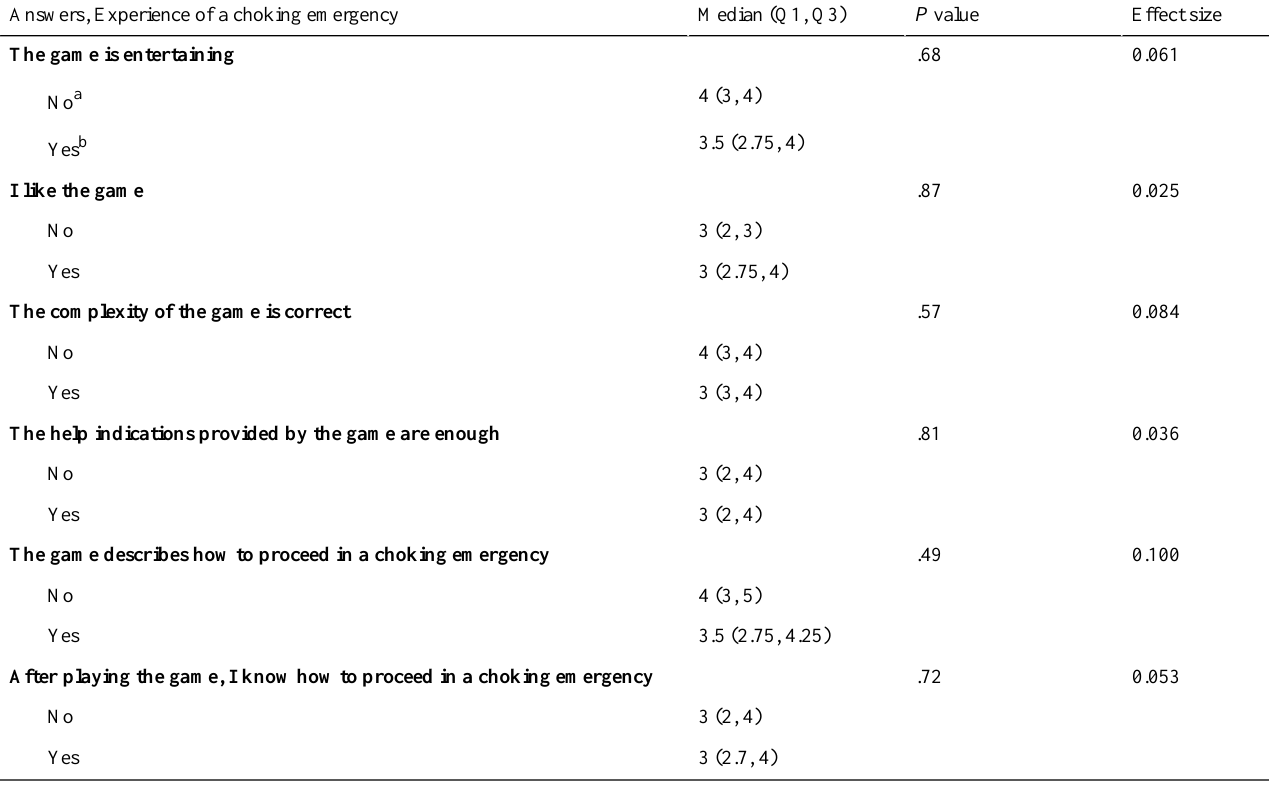
Table 4. Descriptive statistics of the answers to the questions related to the game (grades 1-5) depending on whether the students had previously experienced a choking